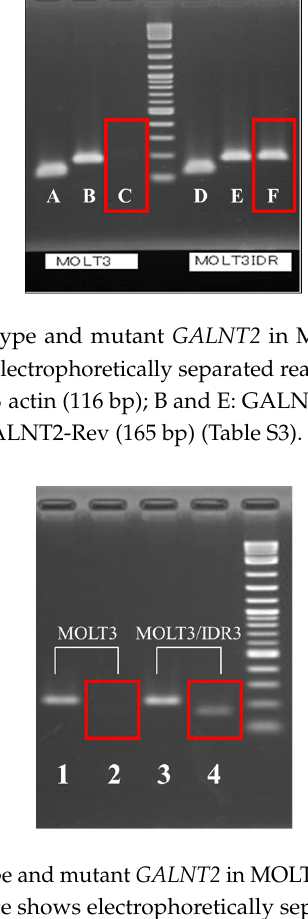
Table 4. GALNT2 mutation expression ratio in MOLT-3/IDR cells relative to MOLT-3 cells.